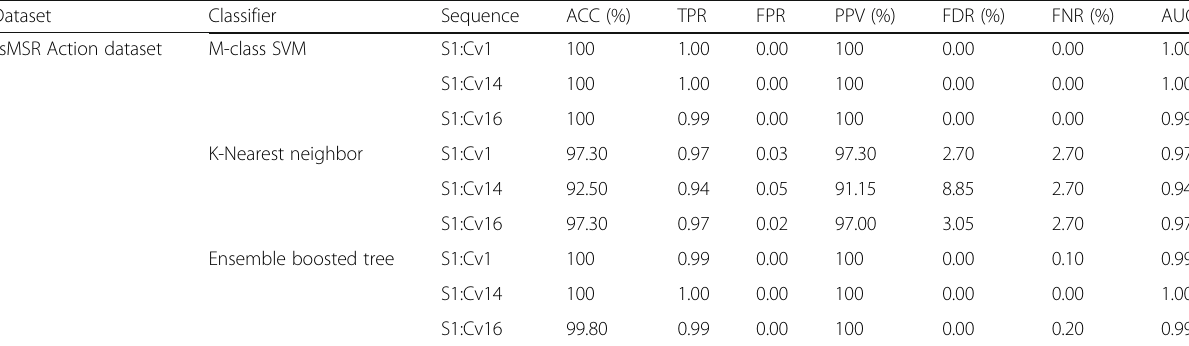
Table 3 Proposed algorithm results using MSR Action dataset Dataset